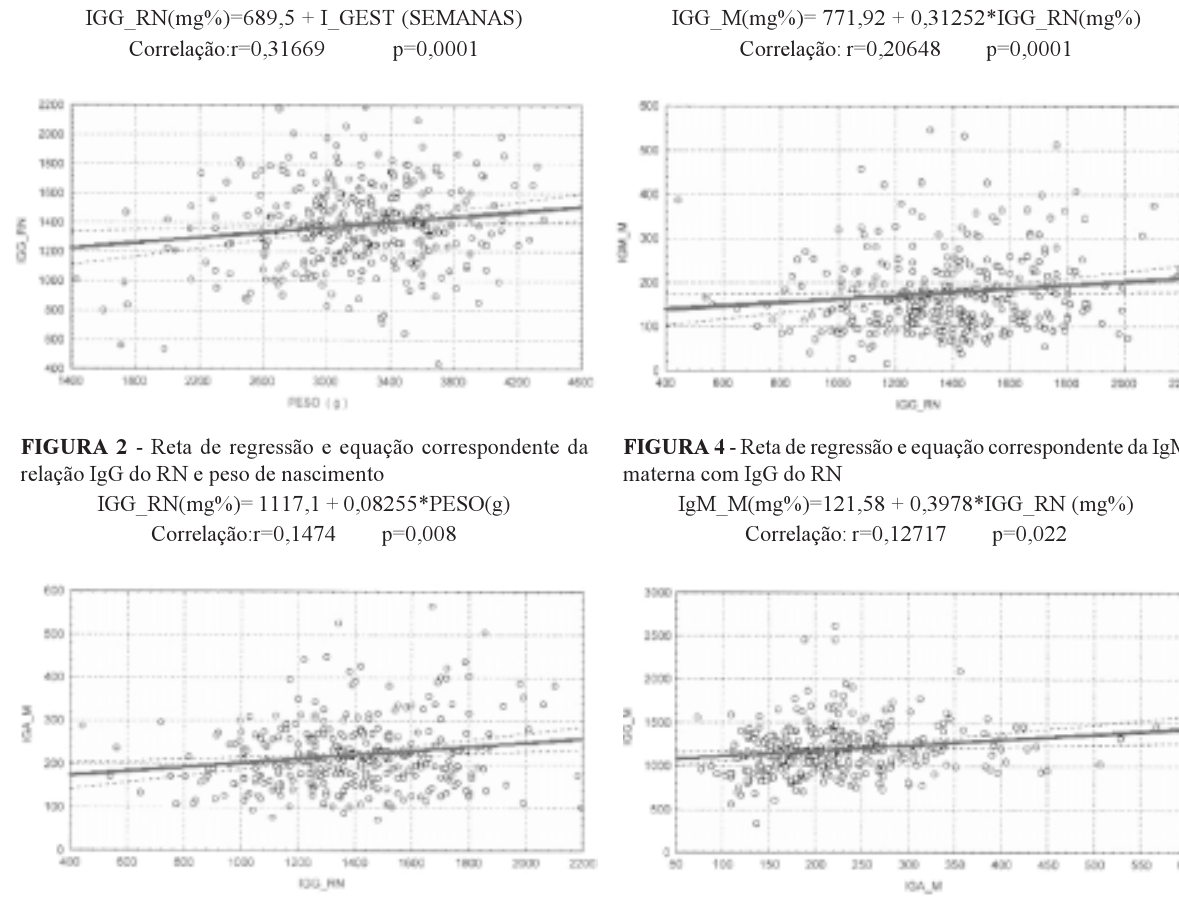
FIGURA 3 - Reta de regressªo e equa(cid:231)ªo correspondente da IgG materna com IgG do RN